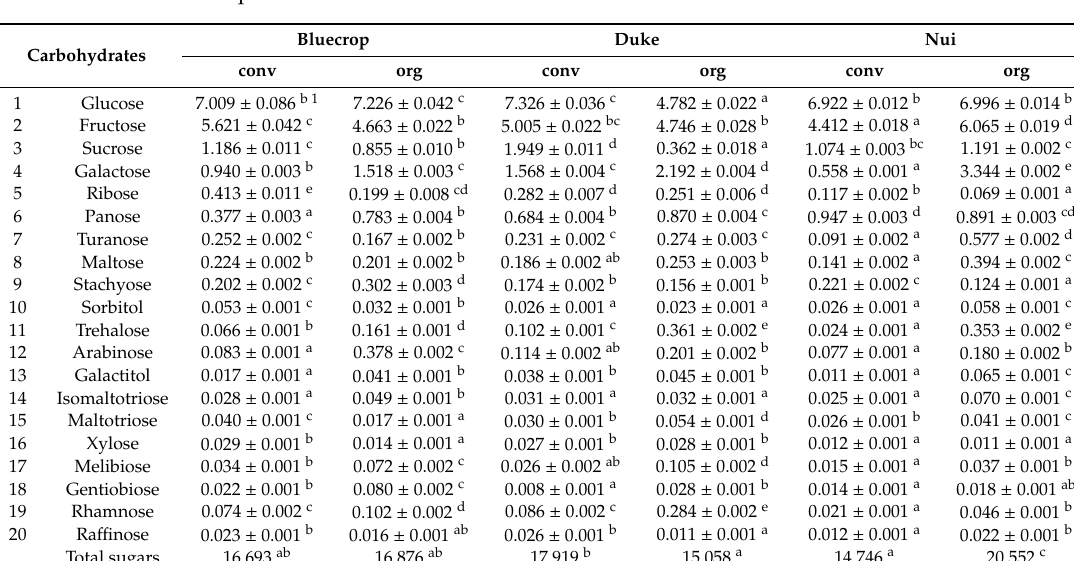
Table 4. Average content of carbohydrates (mg / g) in integrated (integ) and organic (org) blueberry leaves from three